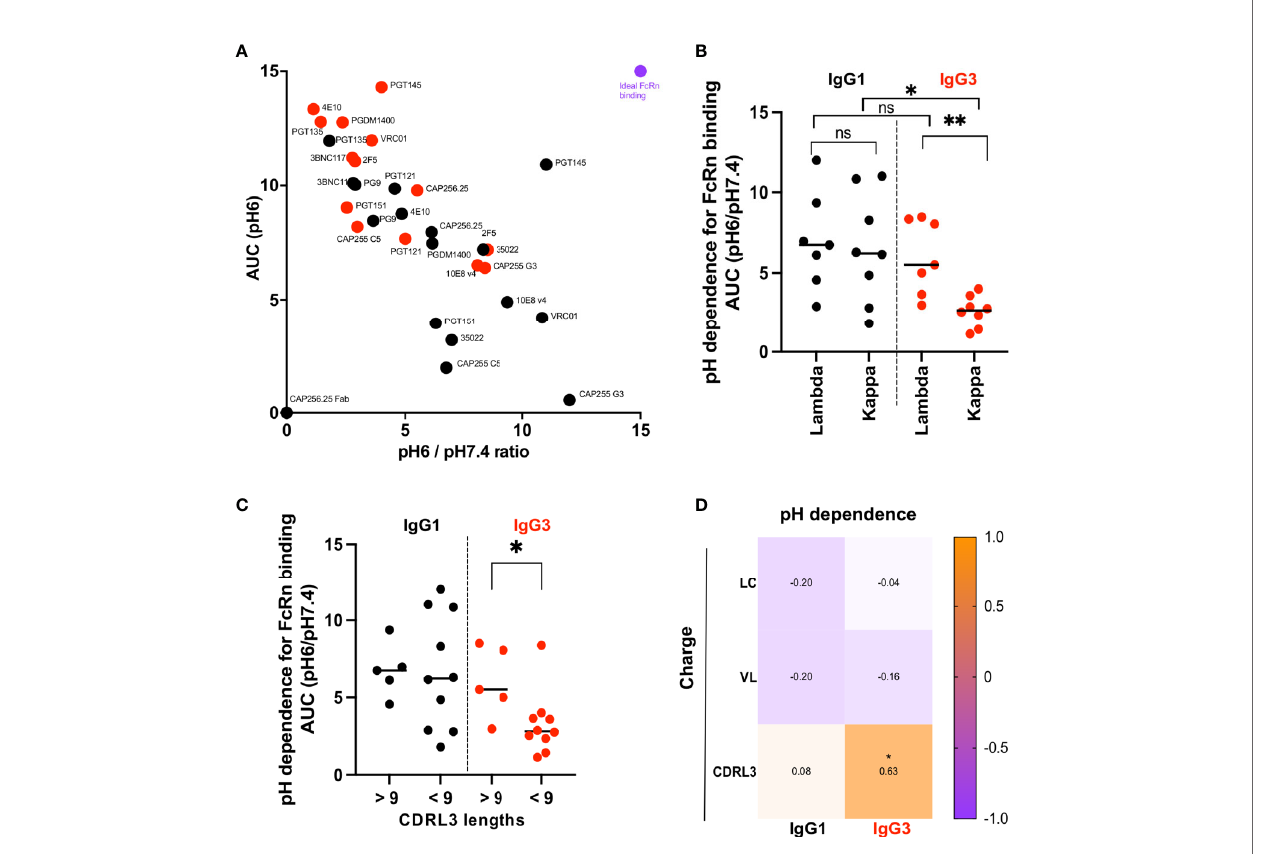
FIGURE 3 | IgG3 bNAb variants with a Lambda light chain show signi fi cantly improved dependence on pH for FcRn binding. (A) Binding to the FcRn receptor measured by ELISA at pH6 and pH7.4. Y axis shows binding to the receptor at pH6 area under the curve (AUC) and the X axis the ratio of the area under the curve of binding to the FcRn receptor at pH6 and pH7.4. Red dots indicate the IgG3 and black the IgG1 bNAb variants. Purple denotes an example of an antibody with optimal FcRn binding. (B) pH dependence (AUC pH6/pH7.4) for antibodies with lambda or kappa light chains. Signi fi cance is indicated by a Mann Whitney t test for unpaired samples (** denotes p < 0,01) and a Wilcoxon paired test for paired samples (* denotes p < 0,05). (C) pH dependence (AUC pH6/pH7.4) for antibodies with CDRL3 lengths below and above 9 are shown with signi fi cance indicated by a Mann Whitney t test where * denotes p < 0,05. (D) Net charge at pH7.4 of the light chain (LC), the variable region of the light chain (VL) and the complementarity determining region 3 of the light chain (CDRL3) correlated with the pH dependence of IgG1 and IgG3 bNAbs (represented as AUC pH6/pH7.4) are shown as Spearman ’ s correlations where * denotes p < 0.05 and ns denotes non-signi fi